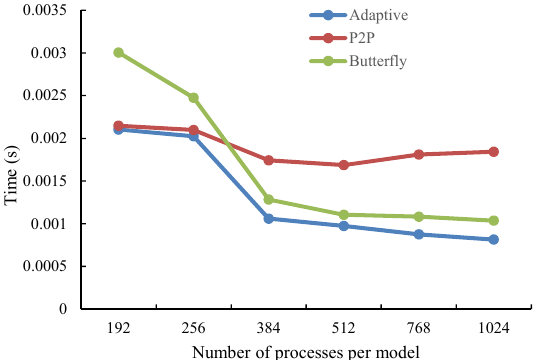
Figure 19. Average execution time ( y axis) of one data transfer between the land surface model CLM4 and the coupler CPL7 in CESM when varying the number of processes per model ( x axis): 32 coupling fields on the CLM horizontal grid (the grid size is 144 × 96 = 13824) are transferred from the land surface model CLM4 to the coupler CPL7. The performance results of the P2P im- plementation are obtained through running the adaptive data trans- fer library forcing it to completely switch to the original P2P imple-